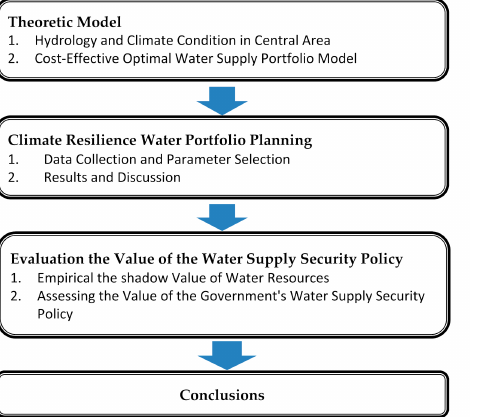
Figure 1. Determination of cost-effective water supply portfolio for water supply security in cen- tral